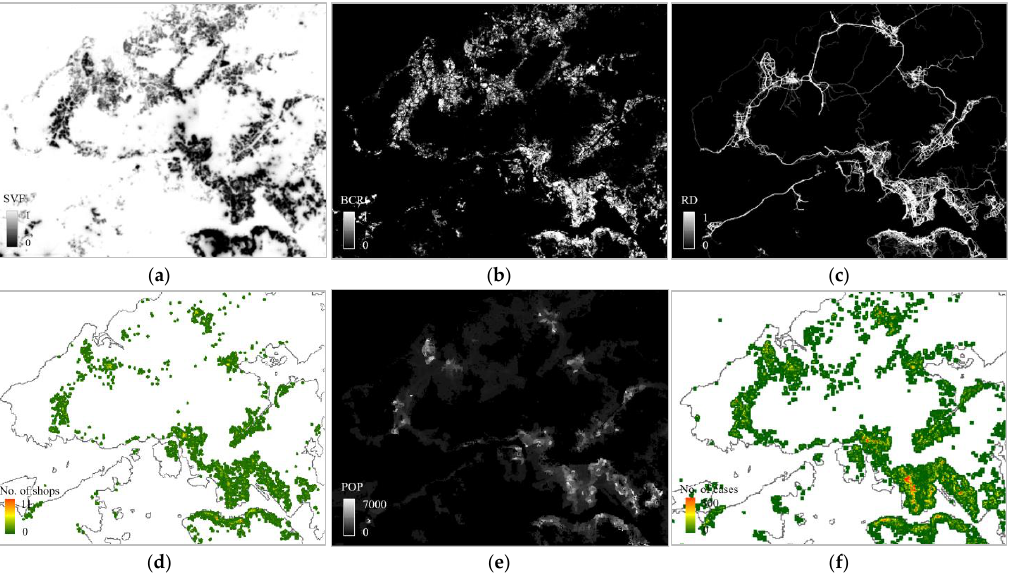
Figure 3. Sample data for Hong Kong: ( a ) Sky view factor; ( b ) building coverage ratio; ( c ) density of roads; ( d ) density of shops; ( e ) population density; ( f ) number of infection cases as a measure of the infection rate.